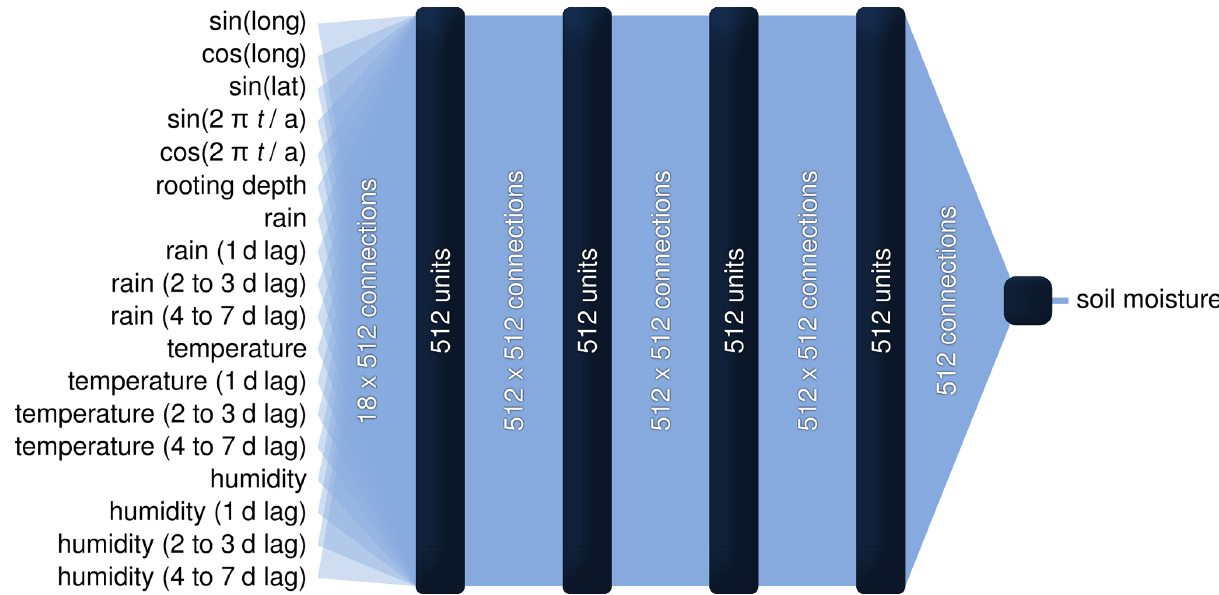
Figure 1. DNN architecture and hyperparameters. The input variables on the left are processed by four fully connected hidden layers of 512 units each to yield the soil moisture on the right. All four hidden layers use a rectified linear unit function activation and during the training use a dropout rate of 10% to avoid overfitting. The output layer with only one unit applies a linear activation function to obtain the final result. The DNN operates on normalised variables with a standard deviation of 1 and mean of